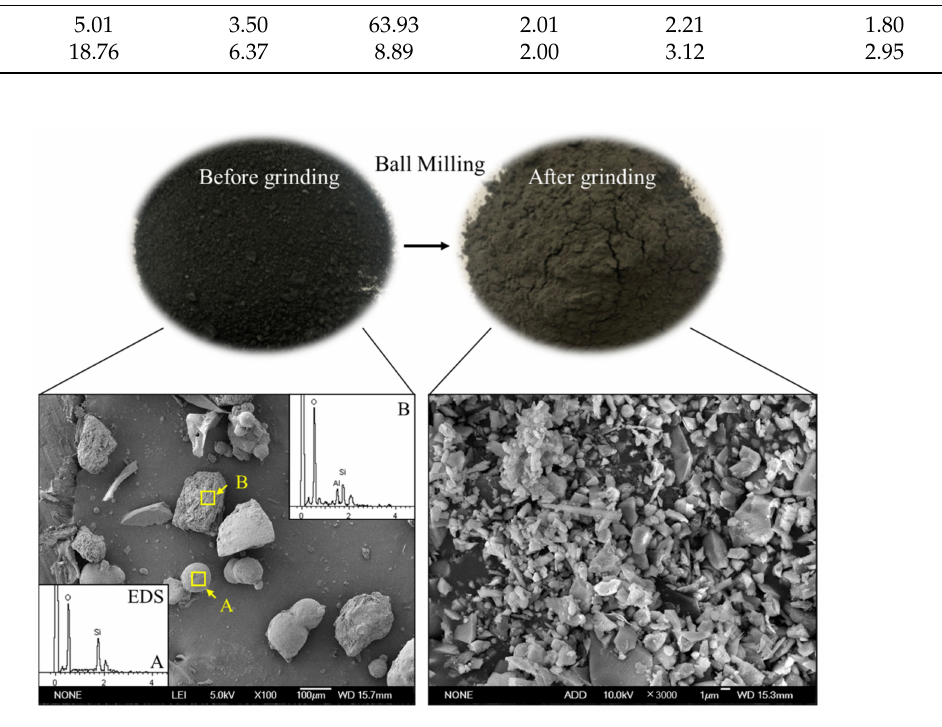
Figure 3. Particle morphology of the GFS powder.